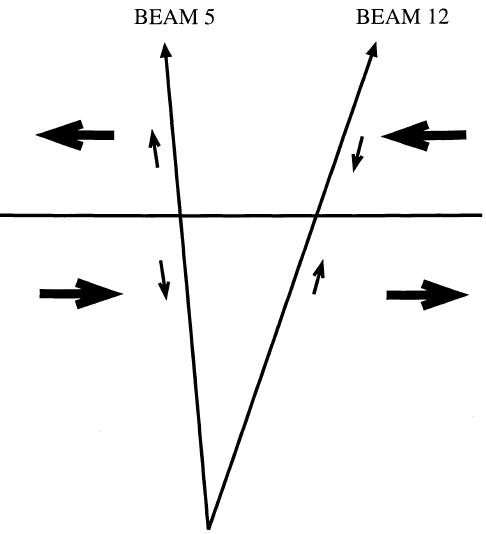
Fig. 2 Schematic representation of the flows detected by the two radar beams during the interval 0600 to 0700 UT. The small arrows depict the direction of l-o-s velocity observed by each radar beam, while the large arrows point in the direction of convection flows consistent with the